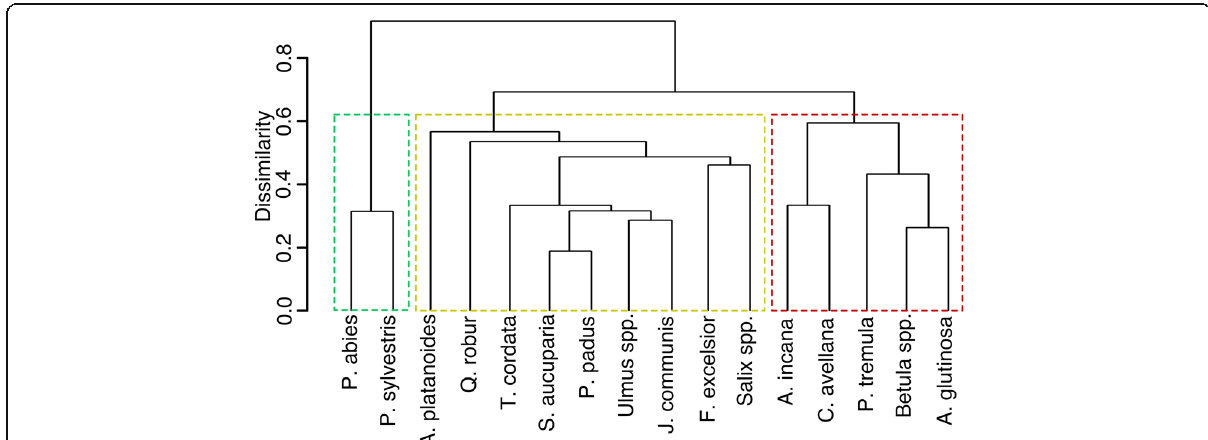
Fig. 5 Similarity of polypore species composition on Estonian native tree species according to cluster analysis (average linkage method; Bray- Curtis dissimilarity). The main clusters of conifers, common soft-wooded deciduous tree species, and remaining tree or shrub species are indicated by coloured